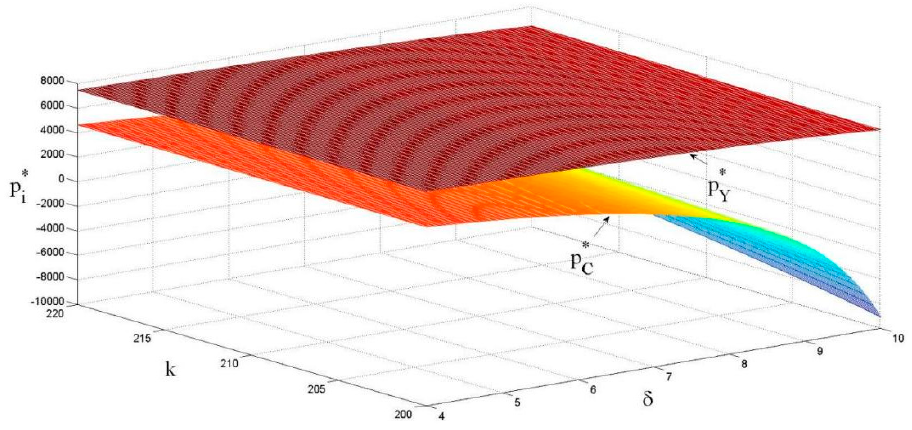
δ δ on the unit retail price of products . Figure 5. The effects of k and δ on the unit retail price of on the unit retail price of products .